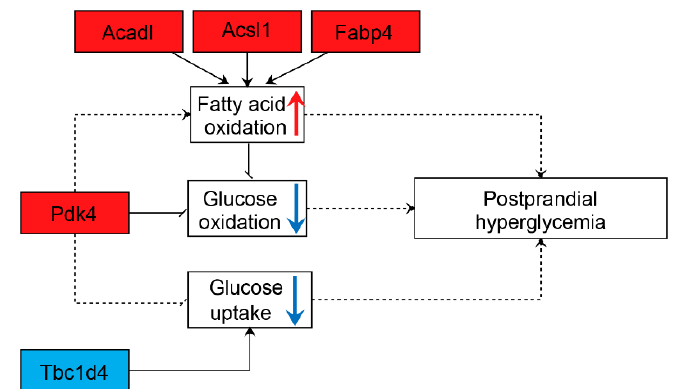
Figure 6. The putative mechanism of postprandial hyperglycemia in GK skeletal muscle during the early stage of three and four weeks. The downregulated expression of Tbc1d4 would reduce the uptake of glucose. The upregulated expression of Acadl , Acsl1 and Fabp4 could contribute to enhanced fatty acid oxidation, which could repress the oxidation of glucose. Moreover, increased Pdk4 expression may not only reduce glucose uptake, but could also reduce glucose oxidation and enhance fatty acid oxidation. Reduced glucose uptake and oxidation, as well as enhanced fatty acid oxidation, may result in postprandial hyperglycemia. The red boxes represent upregulated expression, while the blue box represents downregulated expression. The upward red arrow represents an increase, while the downward blue arrow represents a reduction. The dotted lines indicate that the precise role is unclear.